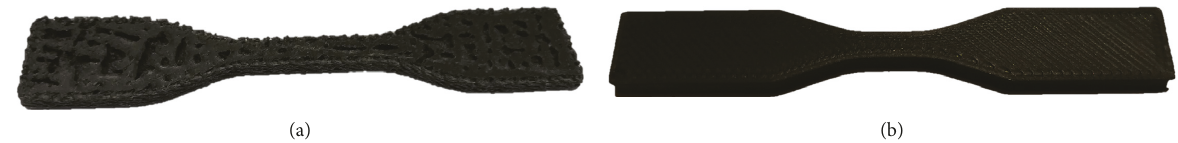
Figure 13: FFF 3D printed specimen from (a) ABS/GO (dry mixing) and (b) ABS/GO (solvent mixing) composite